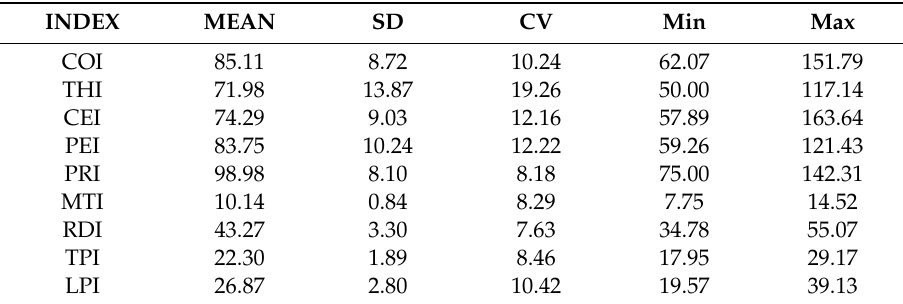
Table 3. Descriptive statistics of zoometric indices.